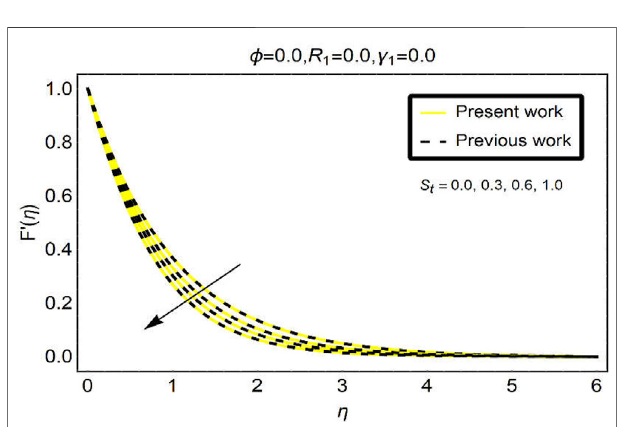
FIGURE 18 | Authentication of the study with a previously reported study.